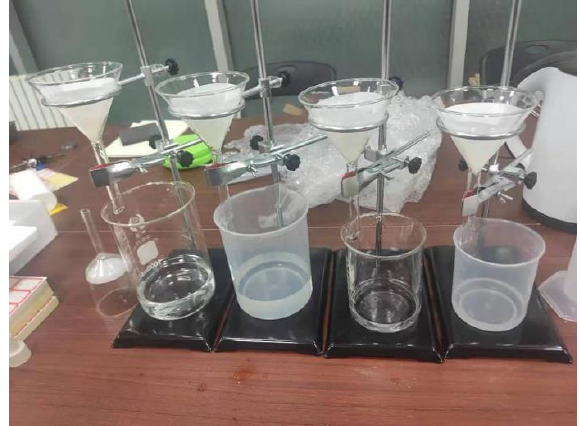
Figure 8. Filtration process.